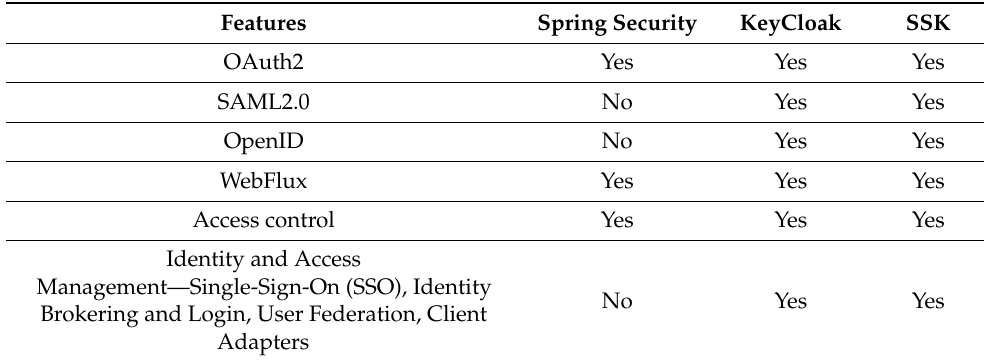
Table 16. Qualitative analysis on the effectiveness of SSK with three flags—No (0), Limited (1), and Yes